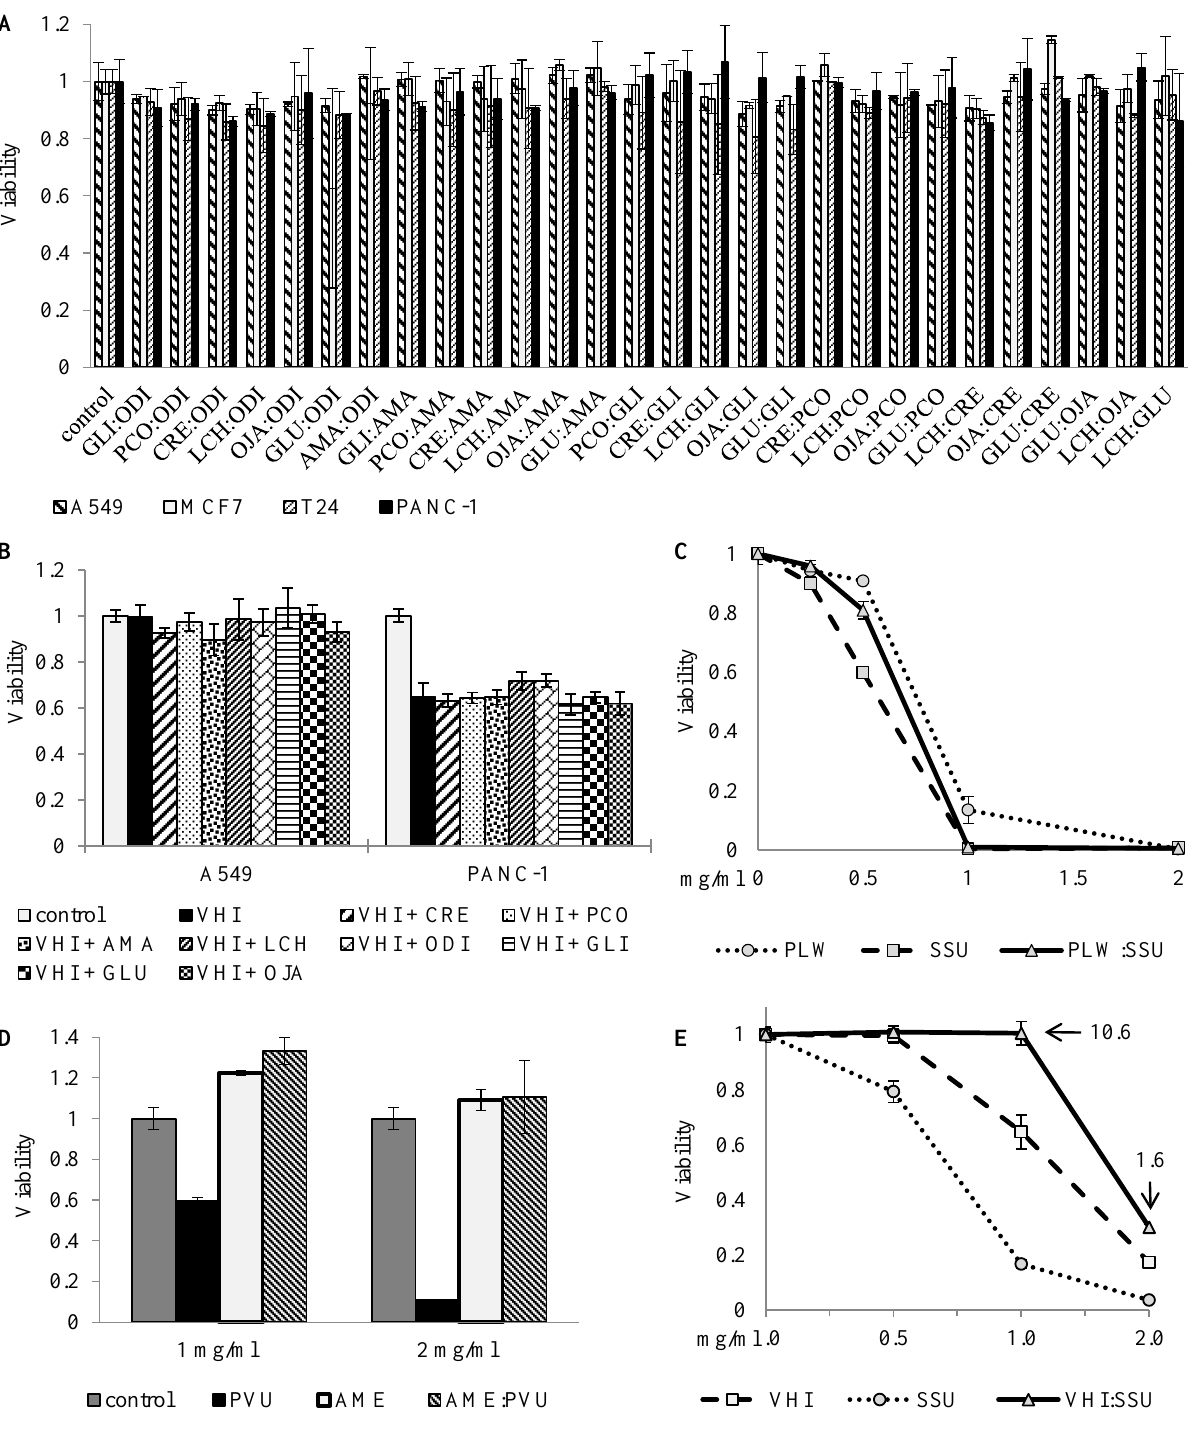
Figure 1. Classification-guided screening two-herb combinations for anti-cancer effect. ( A ) A549, MCF7, T24 and PANC-1 cells were treated for 72 h with 2 mg/mL 1:1 mixes of indicated non-toxic botanicals (average of two independent experiments); ( B ) A549 and PANC-1 cells were treated for 72 h with 1 mg/mL of VHI either alone or with 1 mg/mL of indicated non-toxic botanicals; ( C ) T24 cells treated for 72 h with rising concentrations of ROS-inducing botanicals PLW and SSU or their 1:1 mix; ( D ) Primary ovarian cancer cells treated for 72 h with indicated concentrations of toxic botanicals AME (non-ROS), PVU (ROS) or 1:1 mix; ( E ) PANC-1 cells treated for 72 h with rising concentrations of toxic botanicals VHI (non-ROS), SSU (ROS) or 1:1 mix (the numbers represent combinational index at arrow-indicated points (10.6 at 1 mg/mL and 1.6 at 2